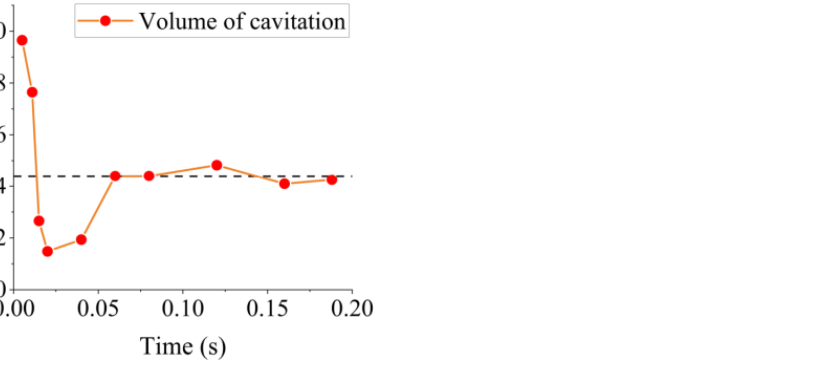
Figure 9. Volume convergence of cavitation with simulation time for Kap01 ( J = 0.5, σ = 2.0).